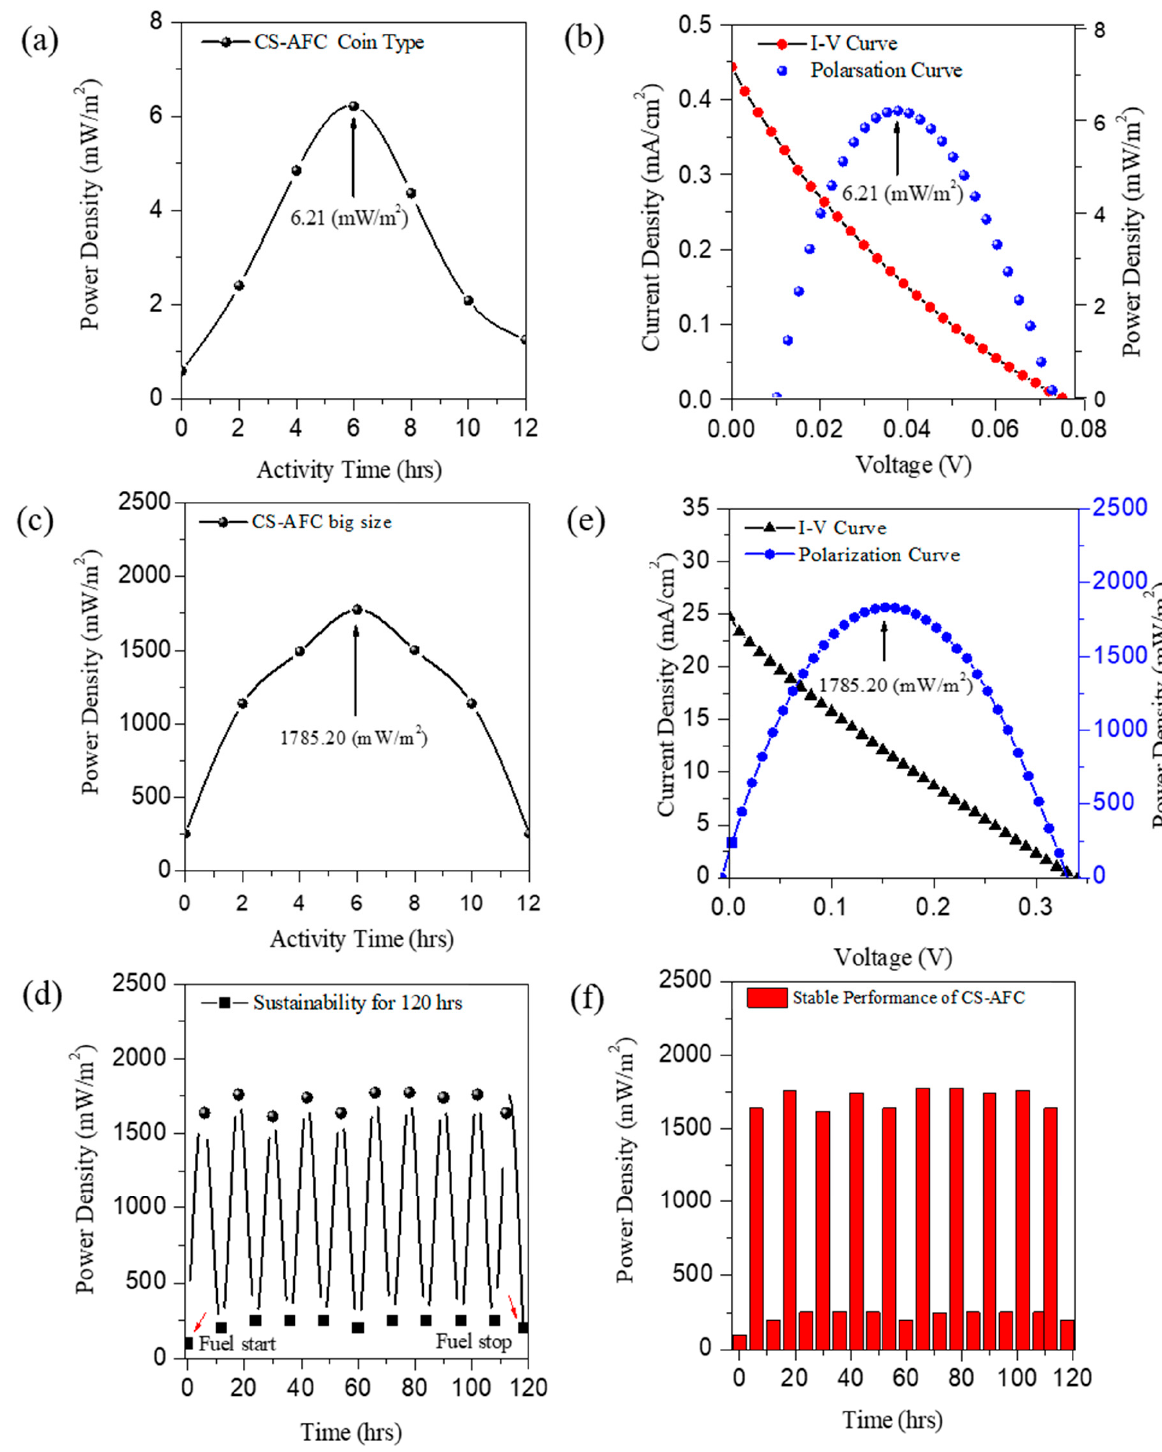
Figure 5. I–V measurement data for the CS-AFC with ferricyanide and 0.2 g/mL fuel concentration. ( a ) Catalytic activity in coin cell with a surface area of 3.14 cm 2 (1–12 h) cycle. ( b ) Polarization curve of the coin cell. ( c ) Catalytic activity for large-sized CS-AFC. ( d ) Polarization curve of the large-sized CS-AFC. ( e ) Sustainability study of the large-sized CS-AFC. ( f ) Stable performance of the CS-AFC.